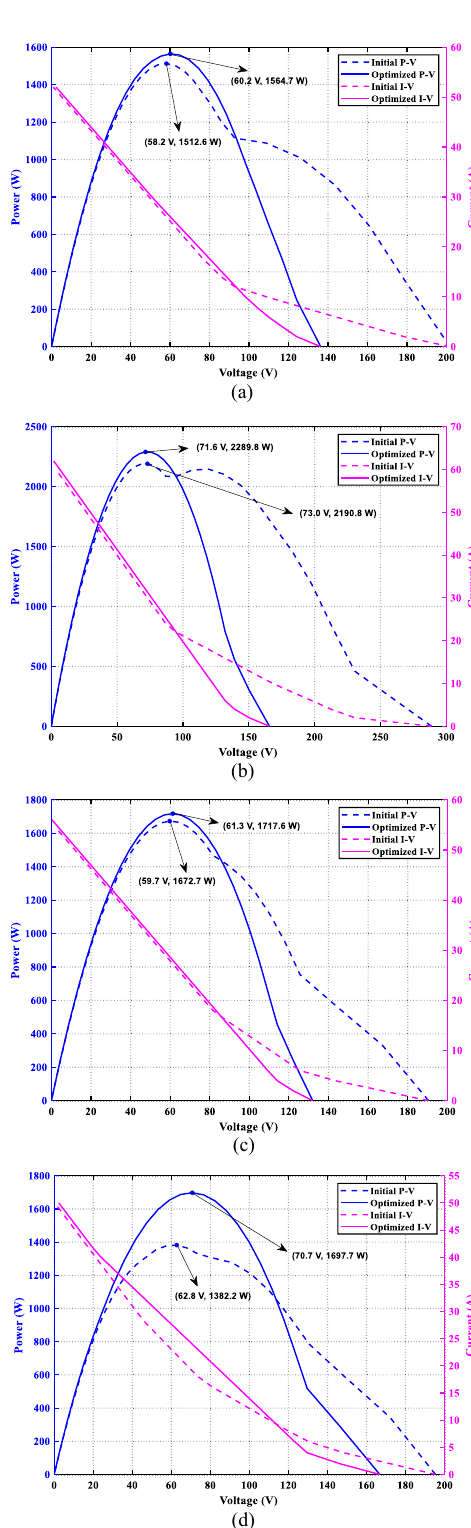
Fig. 9 Output characteristics of (15 different scenarios before and after being optimized by ACS: a diagonal, b outer, c inner, and d